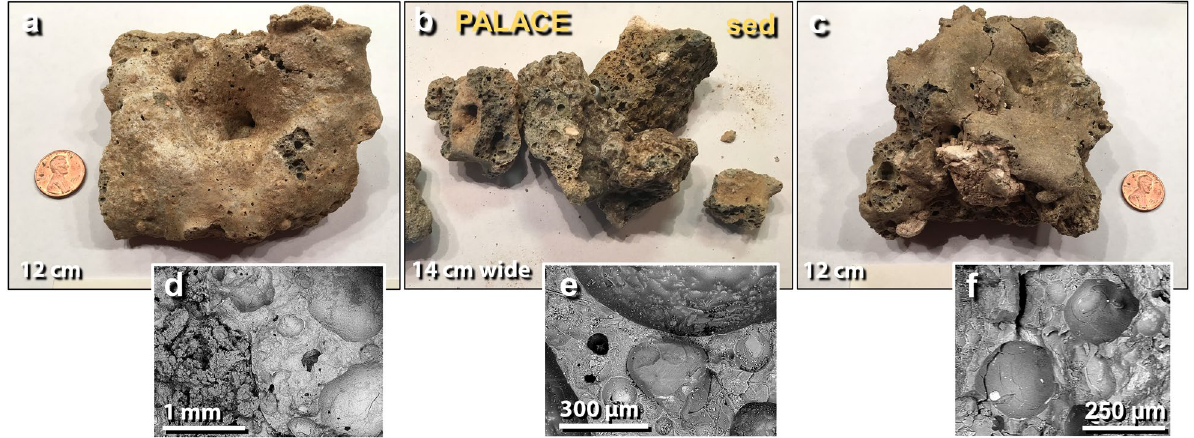
Figure 11. Melted mudbrick from the palace. ( a ) The upper surface of meltglass, showing non-vesicular ‘skin’; ( b ) broken surfaces of meltglass displaying vesicular texture; ( c ) upper surface and broken faces of meltglass. Note large unmelted light-colored mineral inclusion. ( d )–( f ) SEM images of highly vesicular surfaces of broken meltglass. Note bright metallic inclusions in several vesicles.